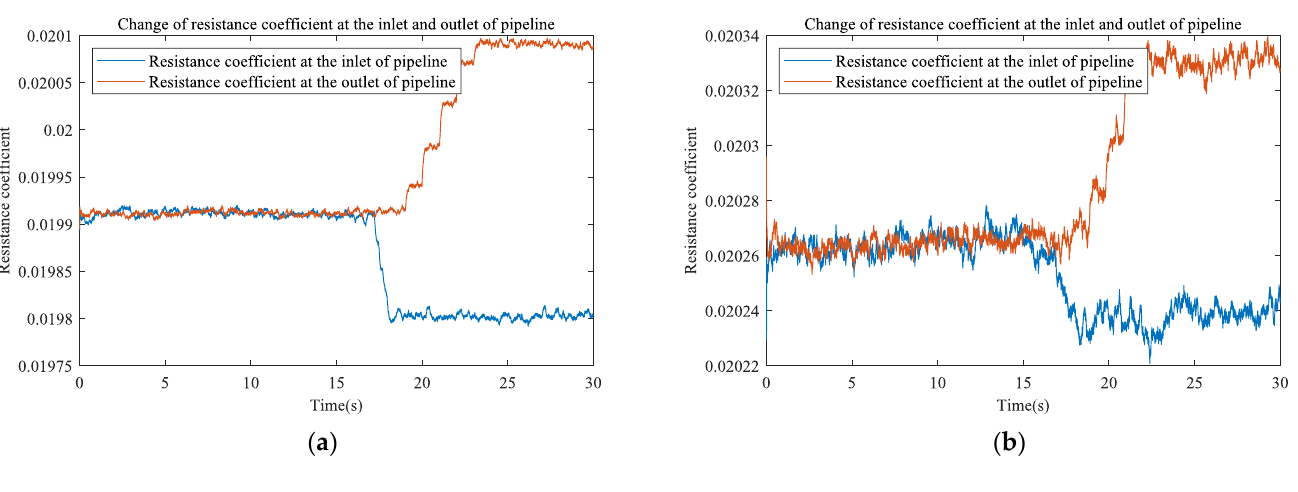
Figure 8. Comparison of resistance coefficients at the inlet and outlet of the pipeline when leakage occurred. ( a ) Large leakage; ( b ) small leakage.